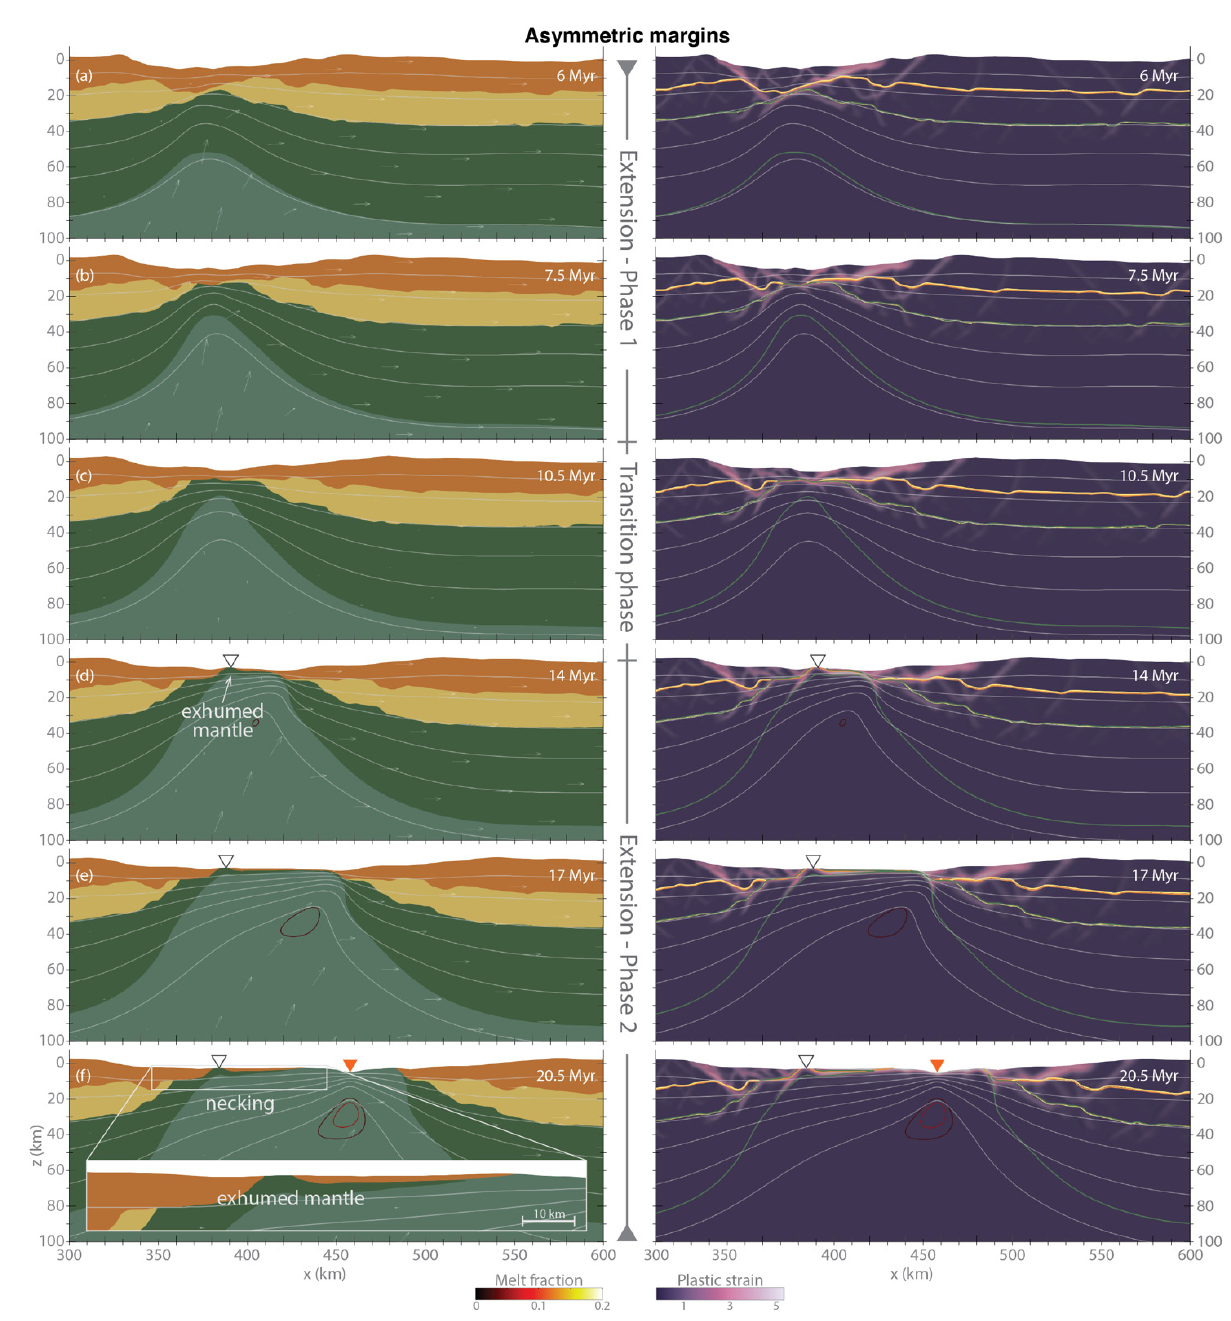
Figure 3. Asymmetric margins. Evolution of model with v 1 = 1 cm/yr, v 2 = 1 cm/yr, and t 1 = 8 Myr. Left column shows the compositional field (see Figure 2 for legend) and right column shows the non-initial plastic strain field ( a , b ) Lithospheric thinning during the first phase of extension, but extension is not enough for mantle melting and spreading ridge to form. ( c ) Pause in extension, from 8 to 11 Myr. ( d ) After extension is resumed lithospheric mantle exhumes in the previous rifting location, then ( e , f ) rifting migrates closer to the trench and continental break-up and spreading ridge formation occur in a new location. At the end of the model, the continental margin on the left of the basin is much more stretched than its conjugate margin on the right. When melt is present, contours of melt fraction are shown. Isotherms are plotted every 200 ◦ C. Empty triangles show the first rifting location, while orange triangle show the location of the spreading ridge during the second phase of extension. Figure S3 in the supplementary material shows the effective viscosity for the same time